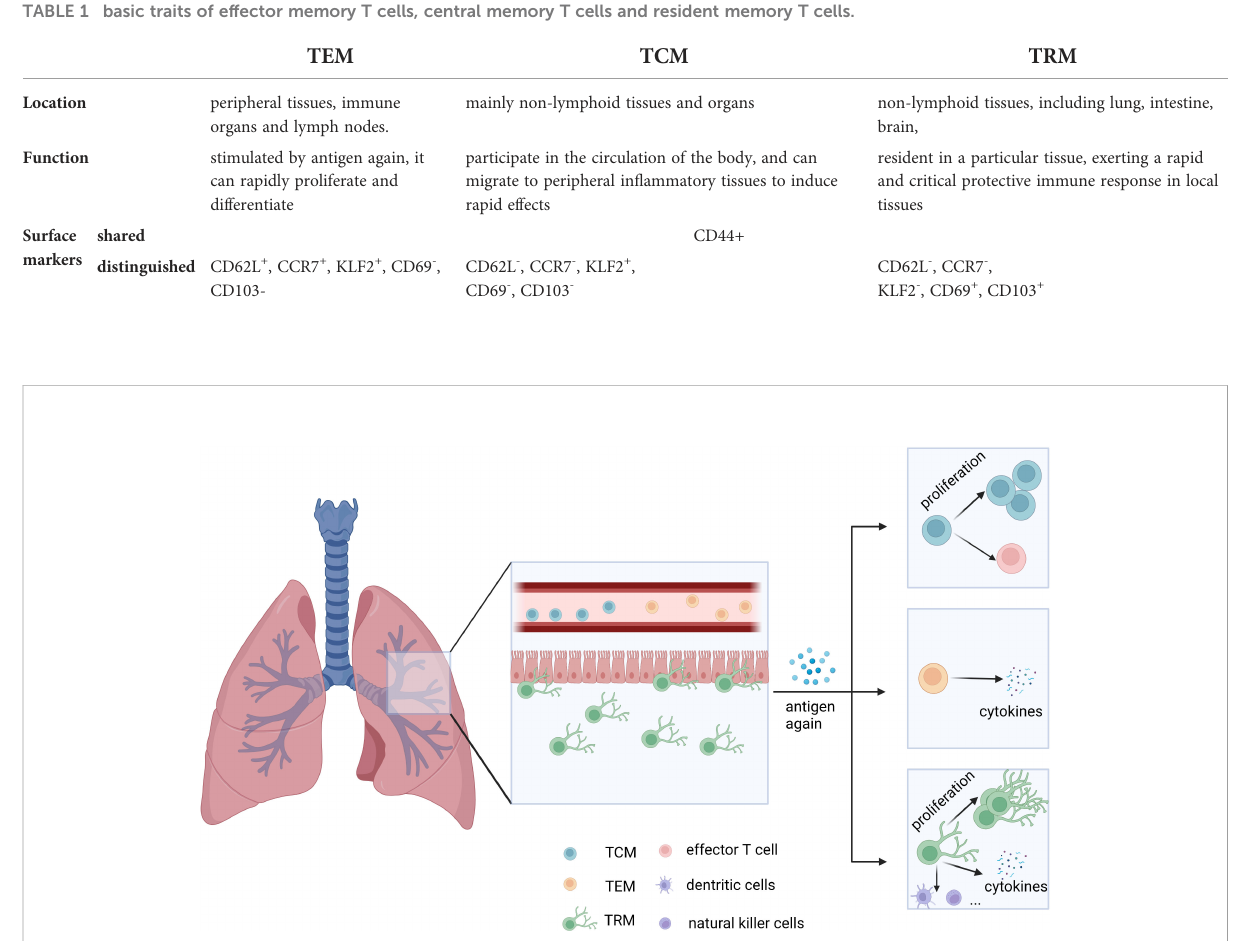
FIGURE 1 General distribution of TEM, TCM, and TRM cells in the lungs and their main mode of function. TEM and TCM cells migrate in circulation, while TRM cells reside in tissues. When stimulated by antigens again, TCM cells rapidly proliferate and differentiate, while TEM cells secrete effector molecules like granzyme B, similar to CD8+ T cells. TRM cells exert a rapid and critical immune response on local tissues. TCM: central memory T cells. TEM: effector memory T cells. TRM: tissue-resident memory T